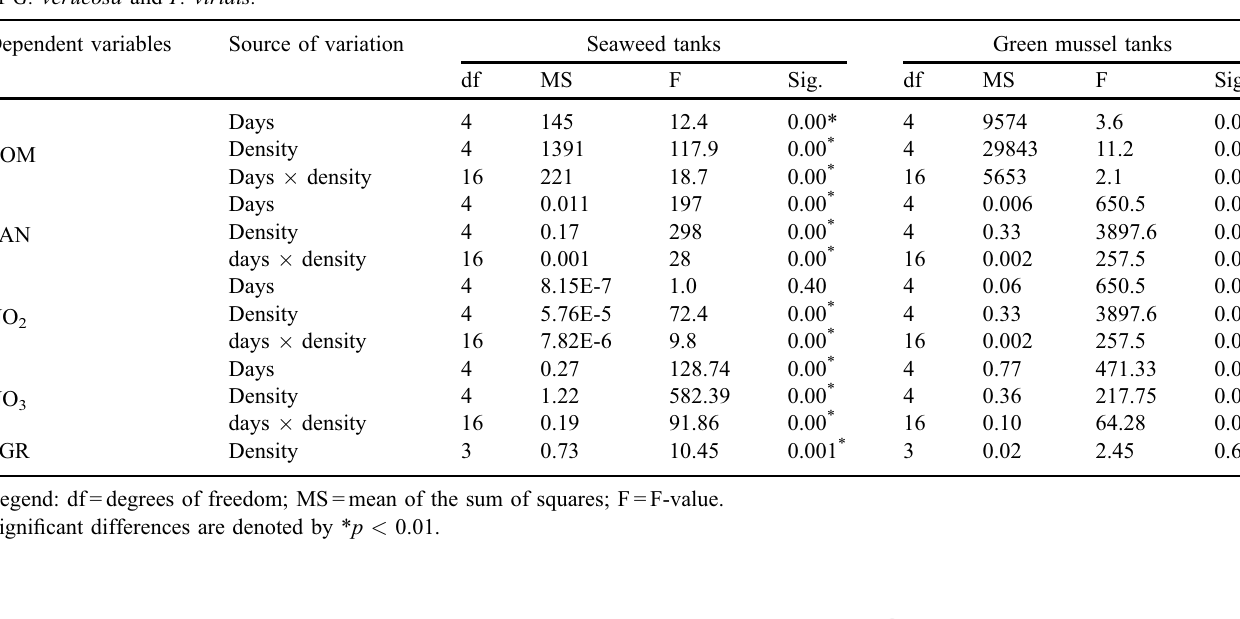
Table 1. Results of the two-way ANOVA testing the in fl uence of days, density, and the interaction on TOM, TAN, NO 2 , NO 3 , and SGR of G. verucosa and P. viridis. Dependent variables Source of variation Seaweed tanks Green mussel tanks